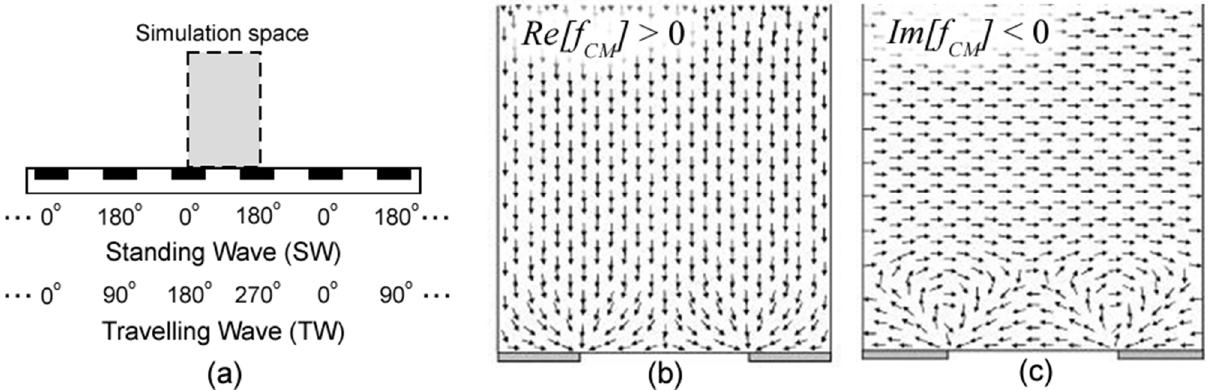
Figure 2. ( a ) Illustration depicting electrode configurations for SW and TW fields. ( b ) Direction of positive DEP force ( Re [ f CM ] > 0). ( c ) Direction of negative twDEP force ( Im [ f CM ] < 0). Both ( b , c ) are modified from [25] .